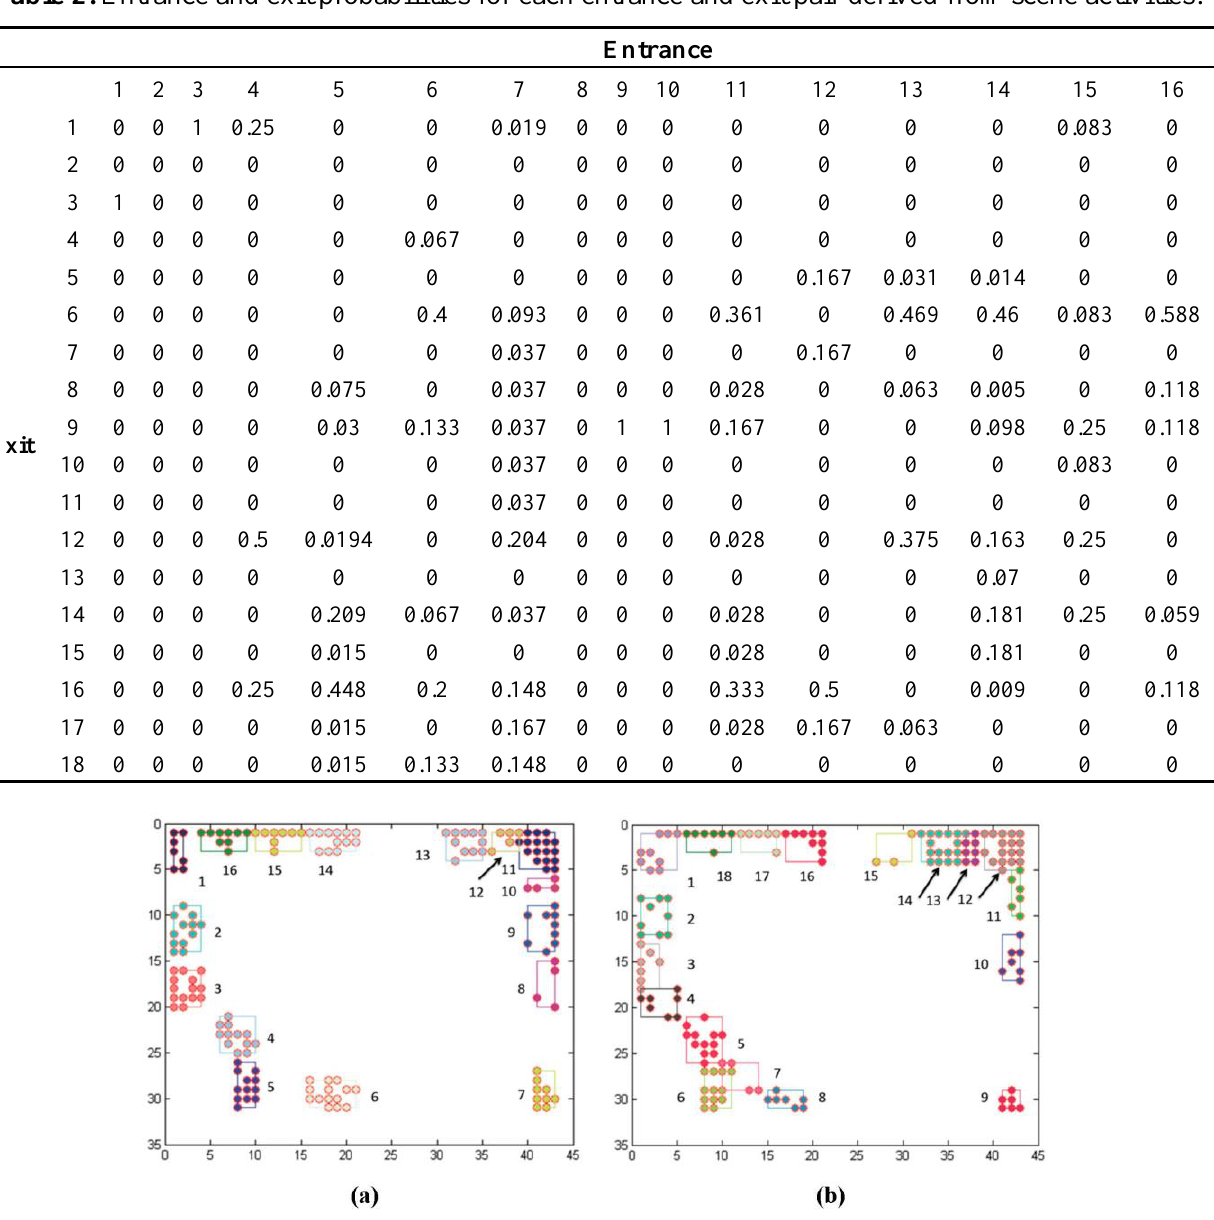
Figure 4. ( a ) Location of Entrances; ( b ) and Exits. Entrance and exit locations are identified from trajectory data and their numbers start at top left and move counter